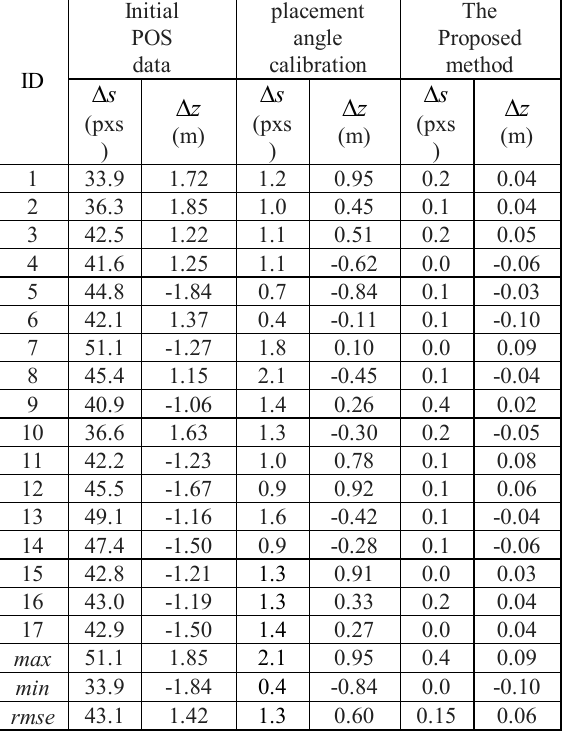
Table 1. Comparison of back-projection of 3D points